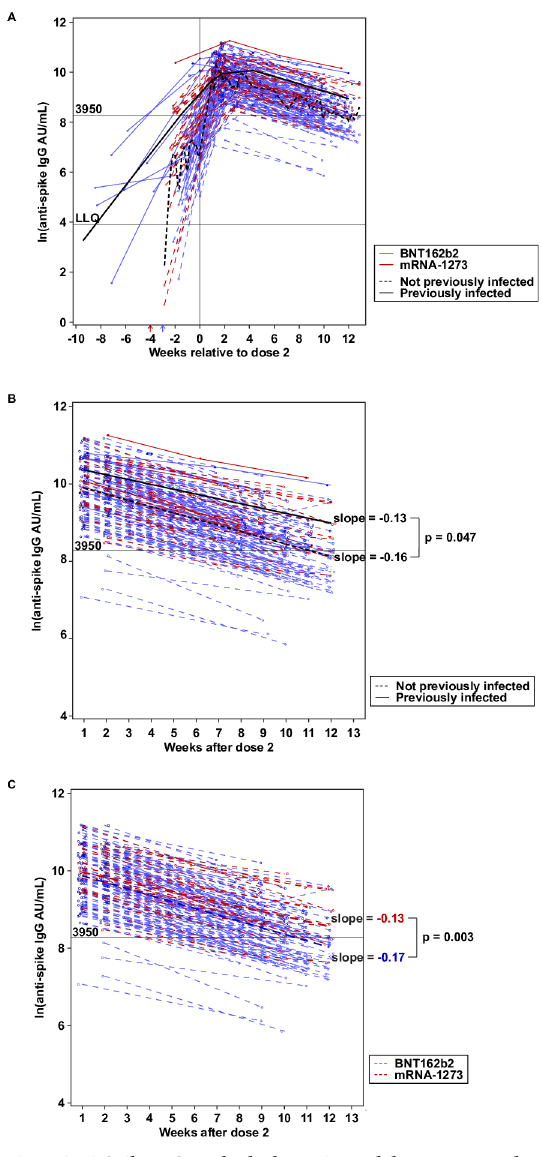
Fig 2. Anti-Spike IgG antibody dynamics and decay up to 90 days post-vaccination. Anti-Spike IgG dynamics and decay in previously infected (solid line, filled circles) versus not previously infected (dashed line, open circles) participants by vaccine type (BNT162b2 in blue, mRNA-1273 in red), as well as slower rate of antibody decay in previously infected individuals (Panel B) and in not previously infected individuals following vaccination with mRNA- 1273. Panel A demonstrates the more rapid rise of antibody titers in PI Individuals following the first dose. Anti-Spike IgG titer is displayed by time before and after the second vaccine dose (vertical black line). Blue and red arrows mark the approximate timing of the 1 st vaccine dose for BNT162b2 and mRNA-1273, respectively. Panel B and C shows the anti-Spike IgG decay after the peak is reached following the 2 nd vaccine dose. The rate of decay is slower in PI (N = 12) versus NPI (N = 168) (Panel B) and in recipients of mRNA-1273 (N = 30) versus BNT162b2 (N = 138) (Panel C).